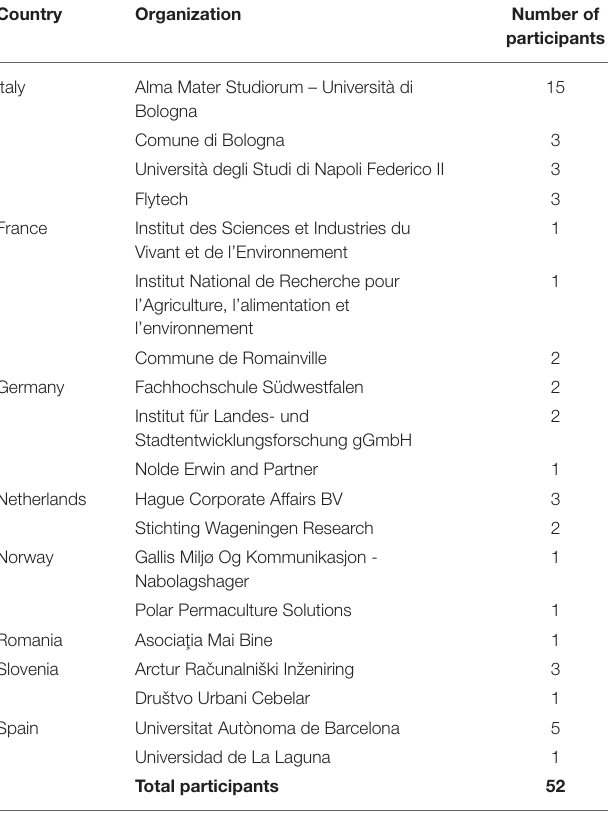
TABLE 1 | Involved participants in the stakeholder’s workshop, per country, and organization.